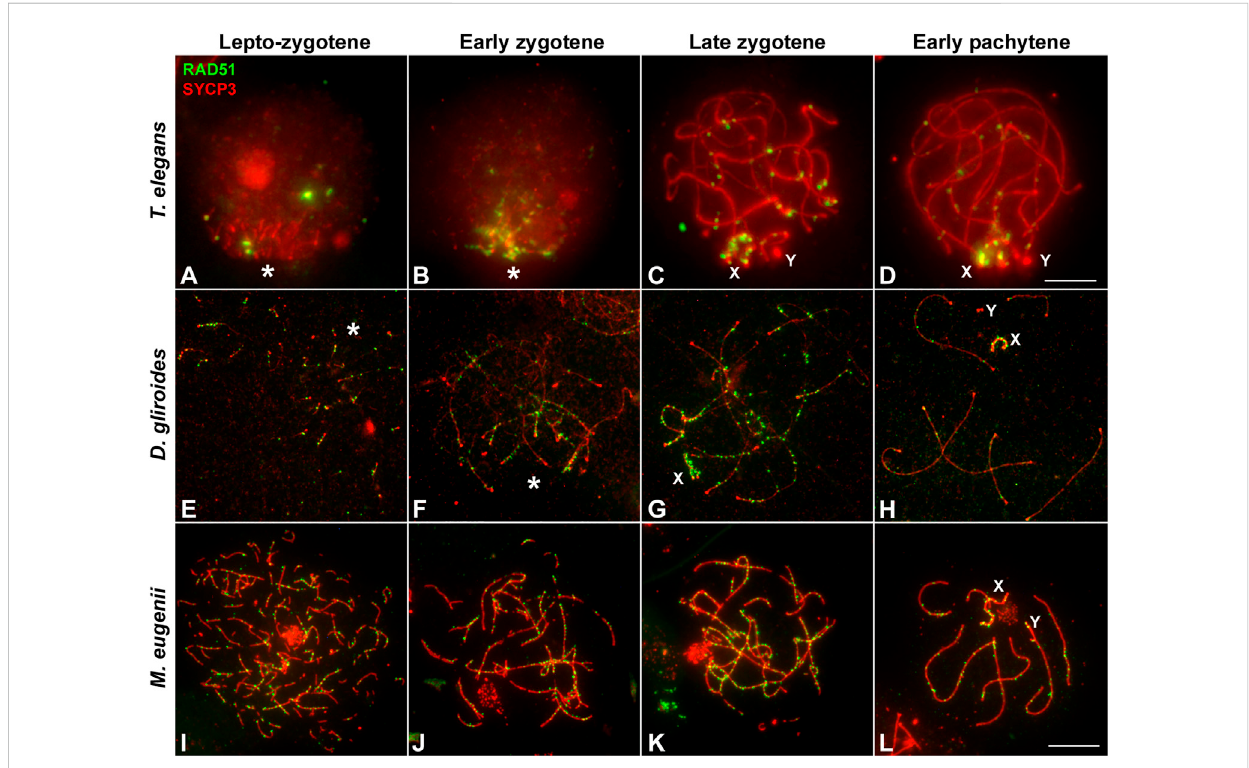
FIGURE 6 Localization of homologous recombination repair. Spermatocytes labeled with antibodies against SYCP3 (red) and RAD51 (green). (A – D) . Thylamys elegans . Squashed spermatocytes. RAD51 foci are scarce and localized in the bouquet (asterisk) during the leptotene-zygotene transition (A) and also at early zygotene (B) . At late zygotene (C) some RAD51 foci are seen at interstitial regions and coat abundantly the X and Y chromosomes (X, Y). At early pachytene (D) mostRAD51fociconcentrateinthesexchromosomes. (E – H) . D.gliroides .RAD51fociassociatetotheshortstretchesofSYCP3atthe leptotene-zygotenetransition (E) .Atearlyzygotene (F) ,mostfociarelocalizedinthealreadysynapseddistalregions.Atlatezygotene (G) discretefociare also detected over the interstitial regions of autosomes and mostly over the X chromosome. At early pachytene (H) , a few foci are still associated